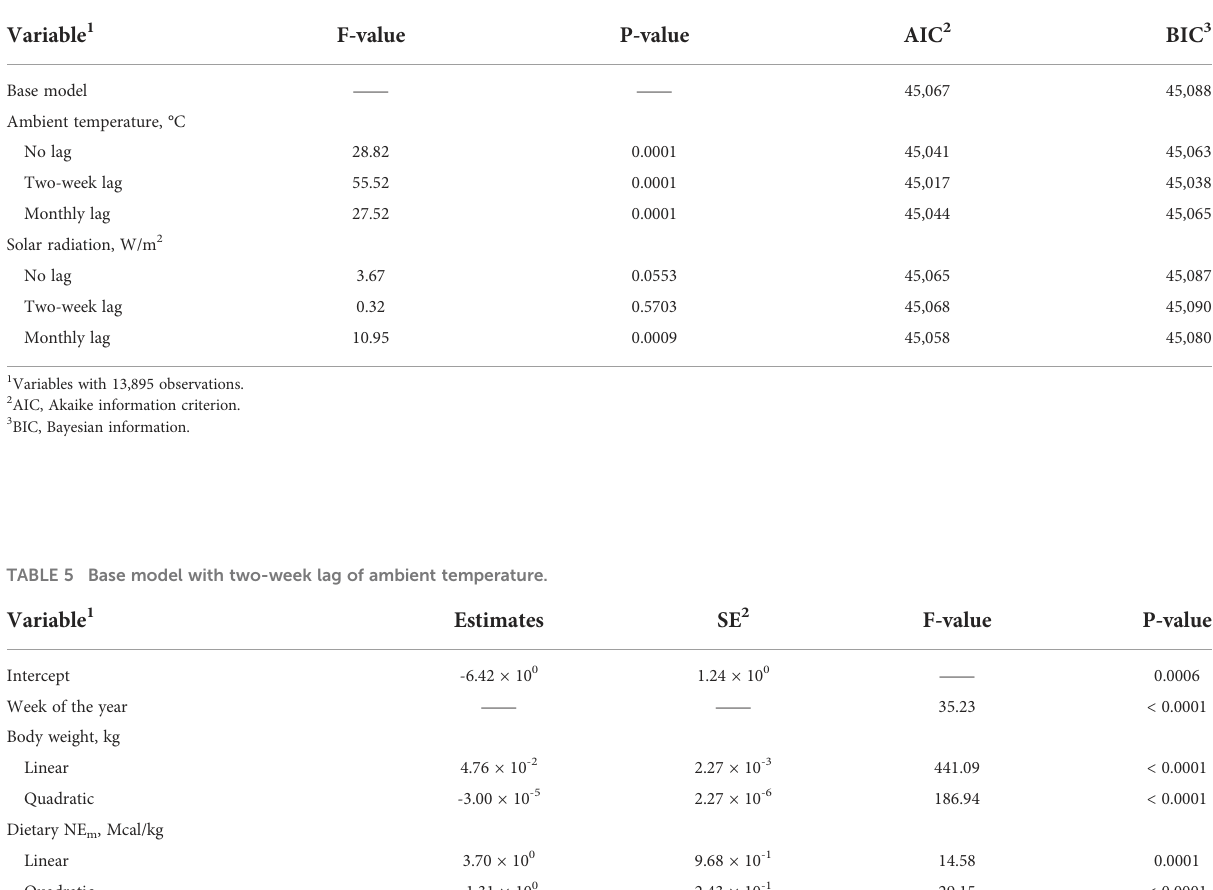
TABLE 4 AIC, BIC, F and P values of each weather variable considered when added to the base model individually using maximum likelihood estimation method